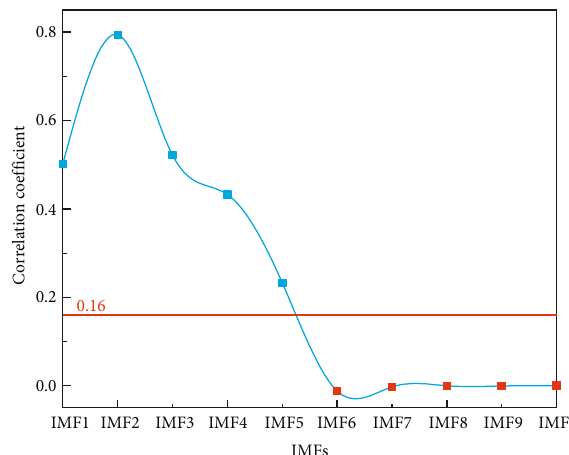
Figure 3: Correlation coefficient